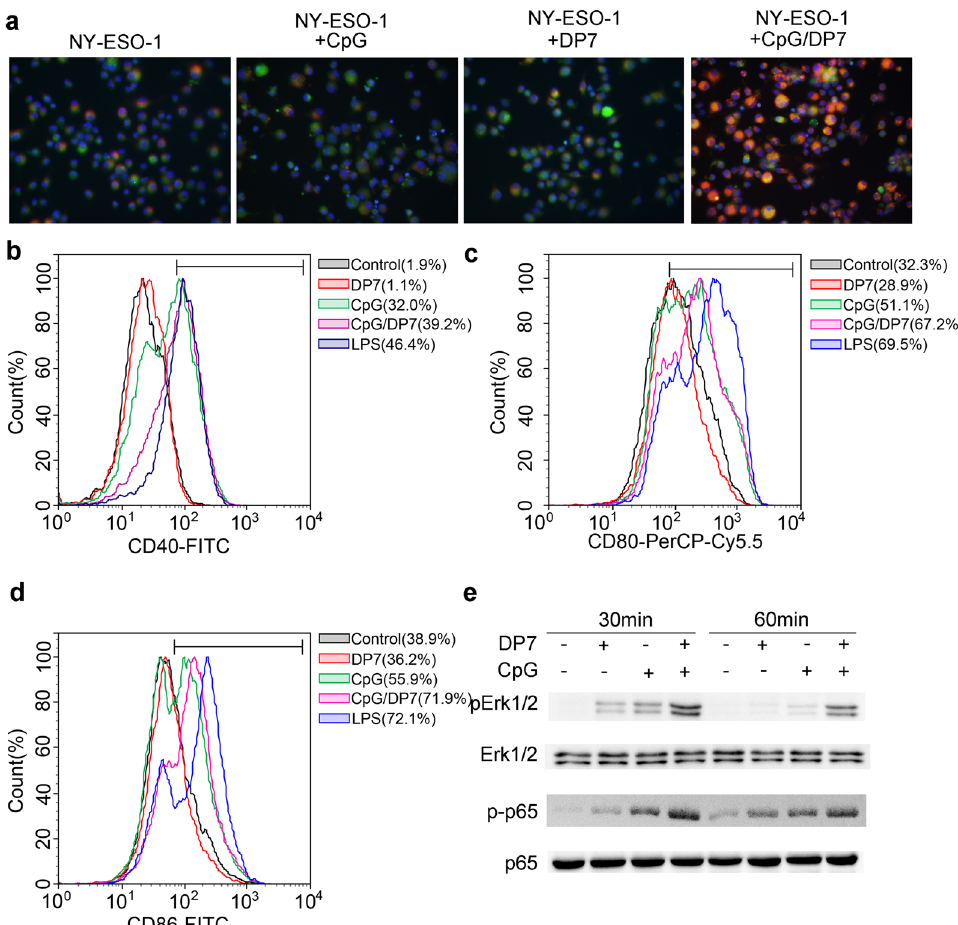
Fig. 2 The effect of the CpG/DP7 complex on BMDC activity. a NY-ESO-1 was labeled with Alexa Fluor ® 594. BMDCs were stimulated with labeled-NY-ESO-1, labeled-NY-ESO-1/CpG, labeled-NY-ESO-1/DP7, or labeled-NY-ESO-1/CpG/DP7 complex for 1 h. Cell membranes tagged with green fl uorescent dye. Cells were fi xed and stained with DAPI followed by observation with confocal microscopy. b – d BMDCs were incubated with CpG, DP7, or CpG/DP7 for 16 h. Then, the surface maturation markers of CD40 ( b ), CD80 ( c ) and CD86 ( d ) in BMDCs were analyzed by fl ow cytometry. e BMDCs were stimulated with CpG, DP7, or the CpG/DP7 complex for 30 or 60 min and then collected to detect the expression of p-Erk1/2 and p-p65 by western